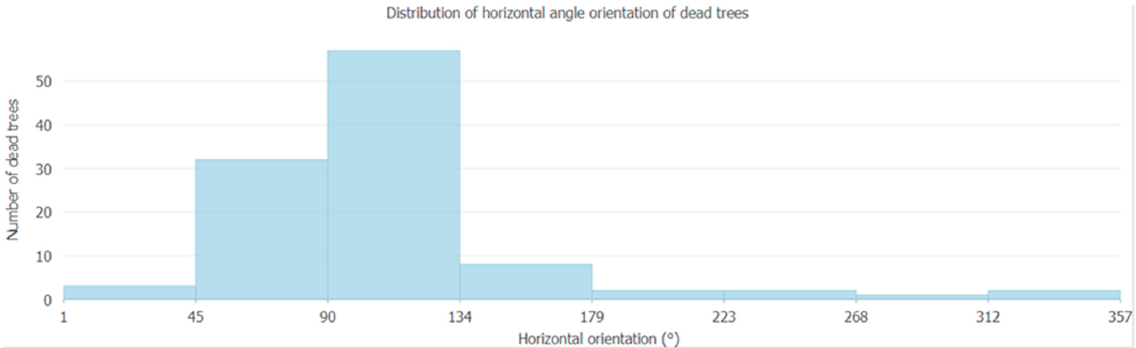
Figure 11. Distribution of the horizontal orientation (in degrees relative to the baseline) of dead Dracaena trees in Firmihin, Socotra Island.